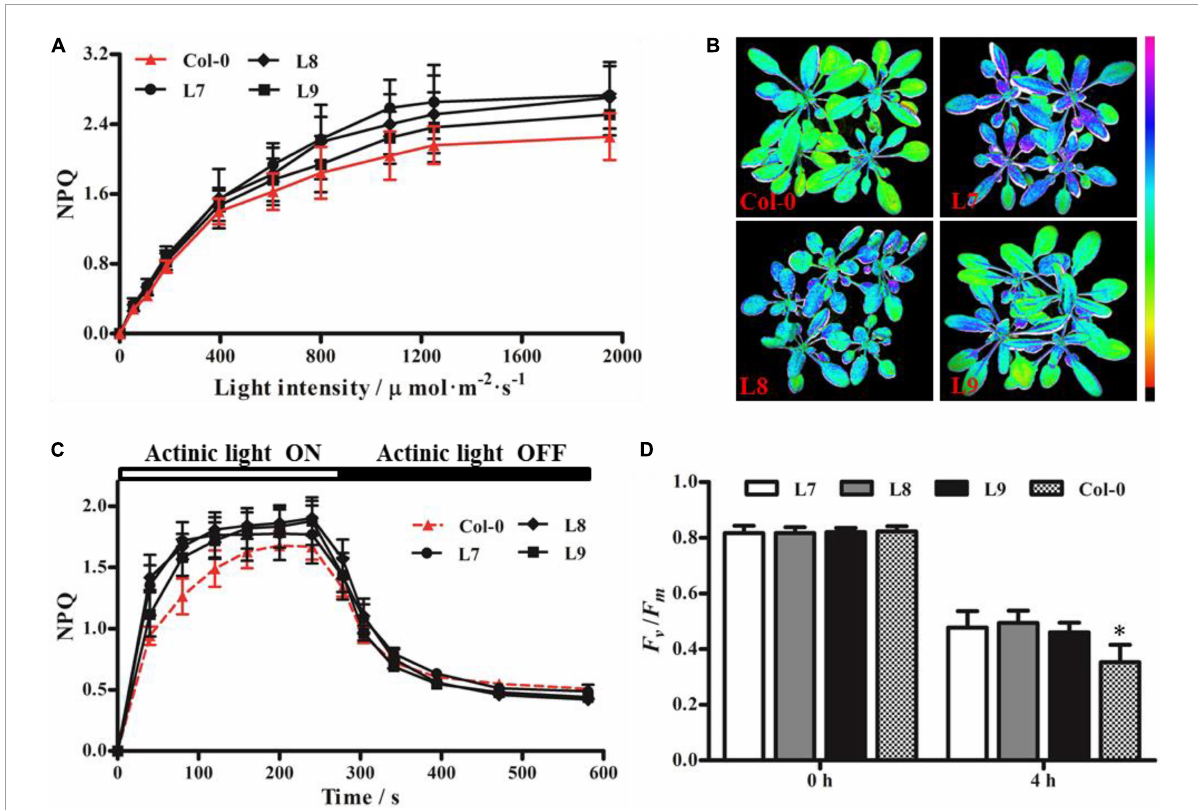
FIGURE7 Chlorophyll fluorescence parameters of Arabidopsis (Col-0) plants overexpressing PeVDE . (A) NPQ of Col-0 and transgenic plants at different light intensities. (B) Chlorophyll fluorescence images of NPQ in Col-0 and transgenic plants at high light intensity (1,250 µ mol · m − 2 · s − 1 ). (C) NPQ kinetics of Col-0 and transgenic plants at 925 µ mol · m − 2 · s − 1 actinic light. (D) Values of F v / F m under high light stress. Asterisks indicate significant differences ( ∗ p <